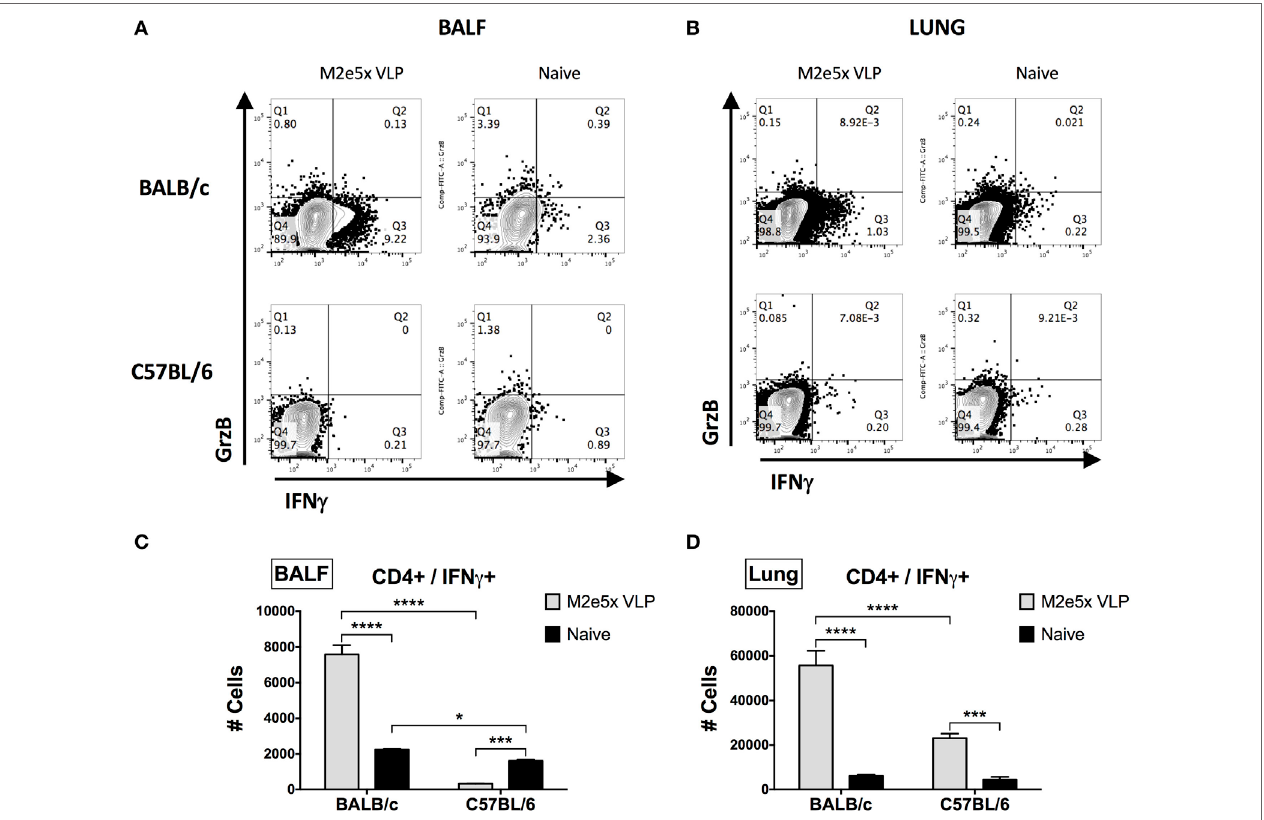
FigUre 4 | Intracellular cytokine staining of CD4 + T cells under the condition of M2e5x virus-like particle (VLP) immunization in C57BL/6 and BALB/c mice after challenge. (a,B) Representative flow cytometry profiles of interferon (IFN)- γ - and granzyme B-secreting CD4 + T cells in bronchoalveolar lavage fluids (BALF) (a) and lungs (B) . (c) The cellularity of IFN- γ -secreting CD4 + T cells in BALF. (D) The cellularity of IFN- γ -secreting CD4 + T cells in lungs. The numbers of cells were indicated as the number per mouse (c,D) . After gating CD4 + cells, IFN- γ + or granzyme B + cells were measured by flow cytometry of intracellularly stained cells. # Cells indicate the numbers in BALF and lungs collected per mouse (c,D) . Data represent the mean ± SEM. Statistical significances were evaluated by two-way ANOVA. * p < 0.05, *** p < 0.001, **** p <